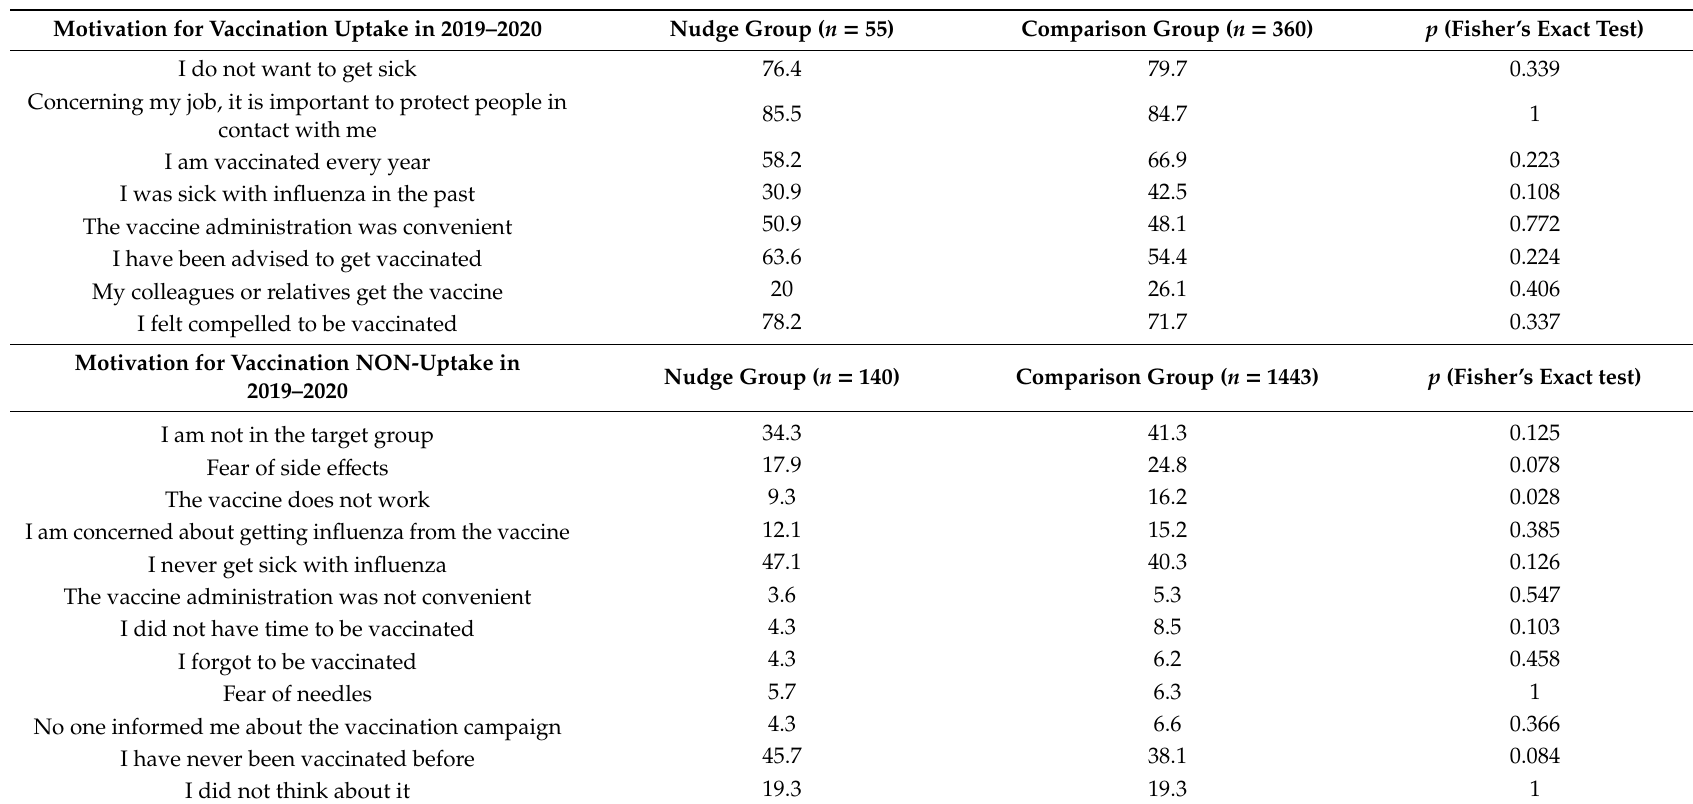
Table 4. Motivation for vaccination uptake or non-uptake in the 2019–2020 season, by